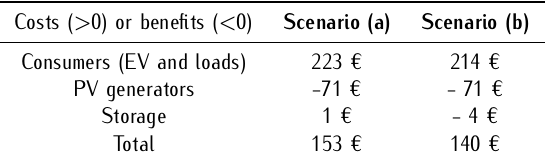
Table 4. Global self-consumption rate for scenarios (a) and (b) Scenario (a) Scenario (b) SC rate 99% 91%